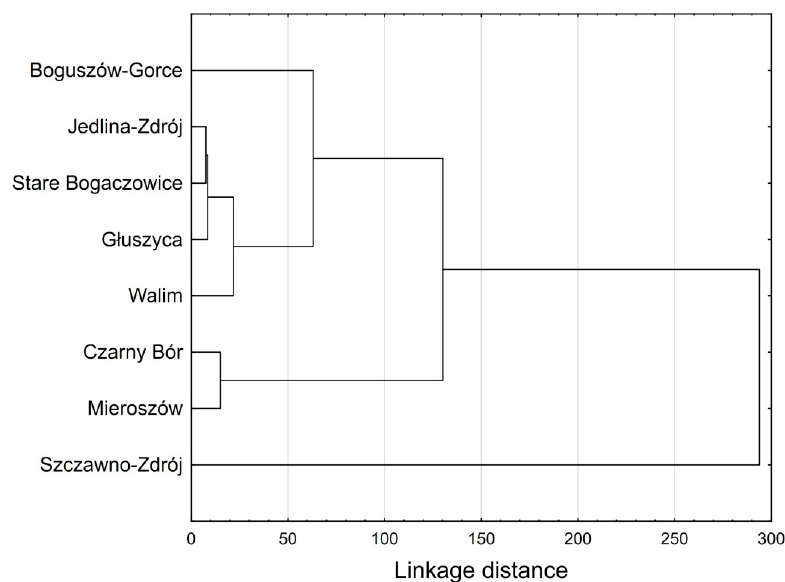
Figure 4. Tree diagram of social potential 2016–2018. Source: authors’ compilation based on